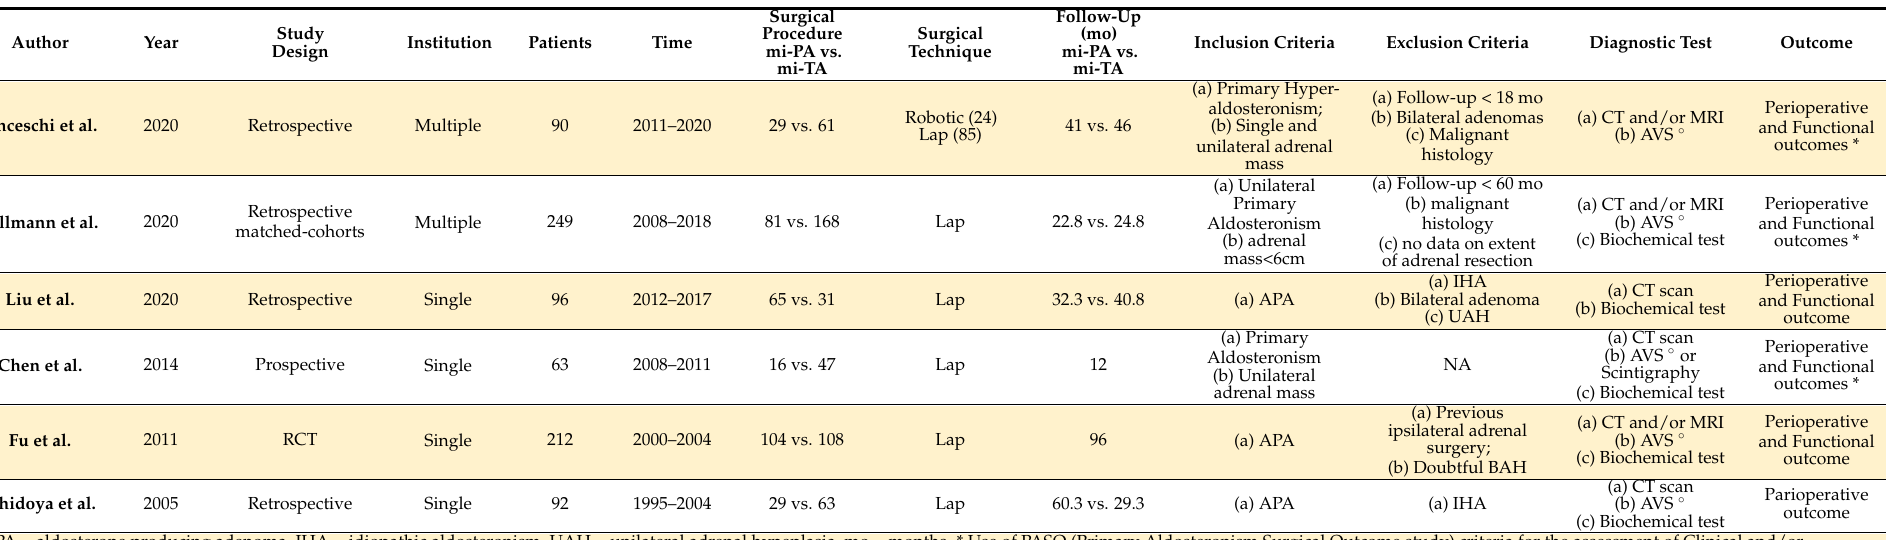
Table 1. Summary of published research: eligible studies testing perioperative and functional outcomes of mi-PA versus